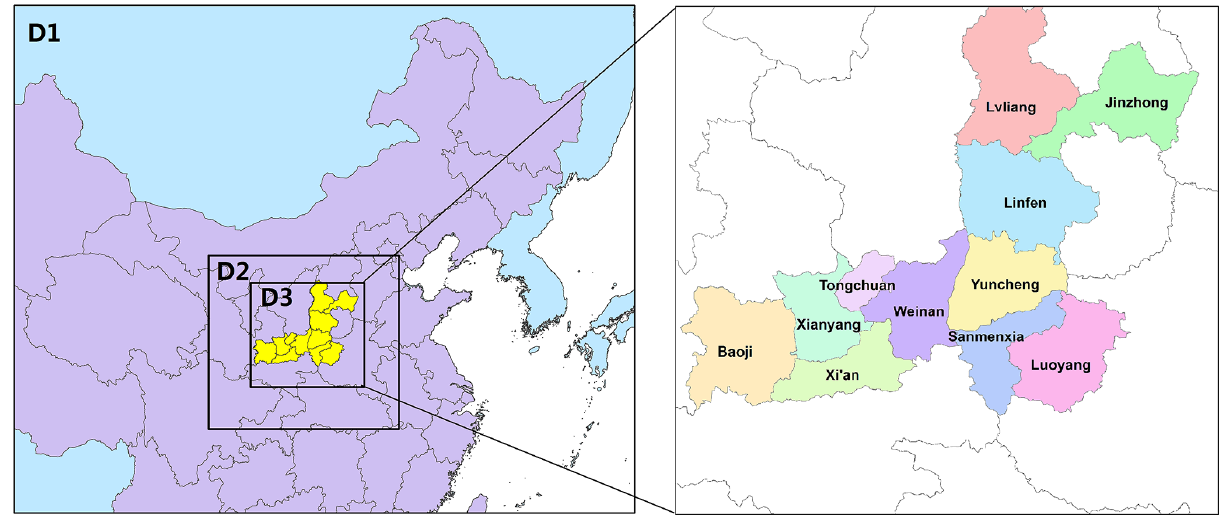
Figure 4. The three nested model domains with respective horizontal resolutions of 27km × 27km (D1), 9km × 9km (D2), and 3km × 3km (D3) in the WRF-CAMx modelling system. D1 covers most parts of China, with 148 × 121 grids, and D2 includes Shaanxi, Shanxi, and Henan provinces. The inner domain covers Fenwei Plain, including